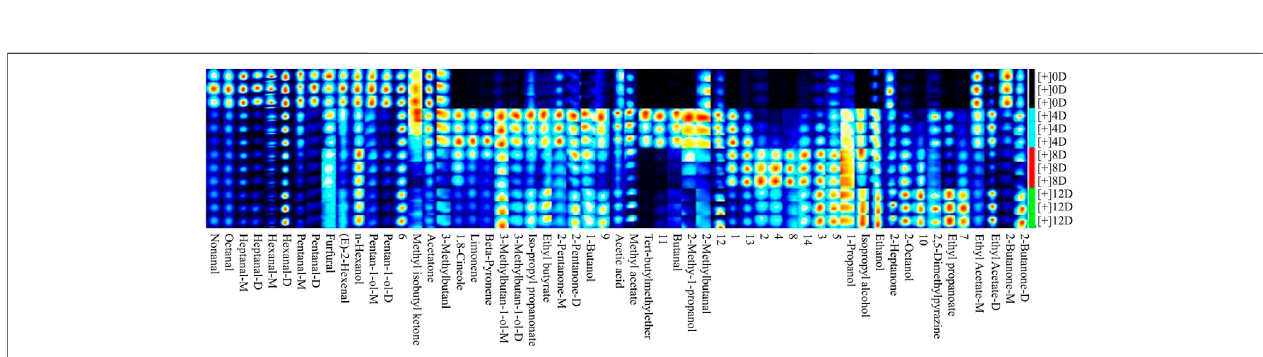
FIGURE 5 | Gallery plot fi ngerprint pro fi les of volatile compounds in fermented mandarin fi sh. Values are obtained from three biological replicates.